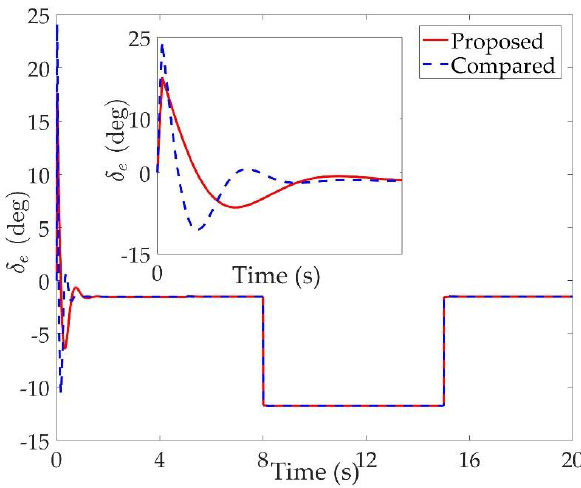
Figure 8. Comparison curves of the left elevon.